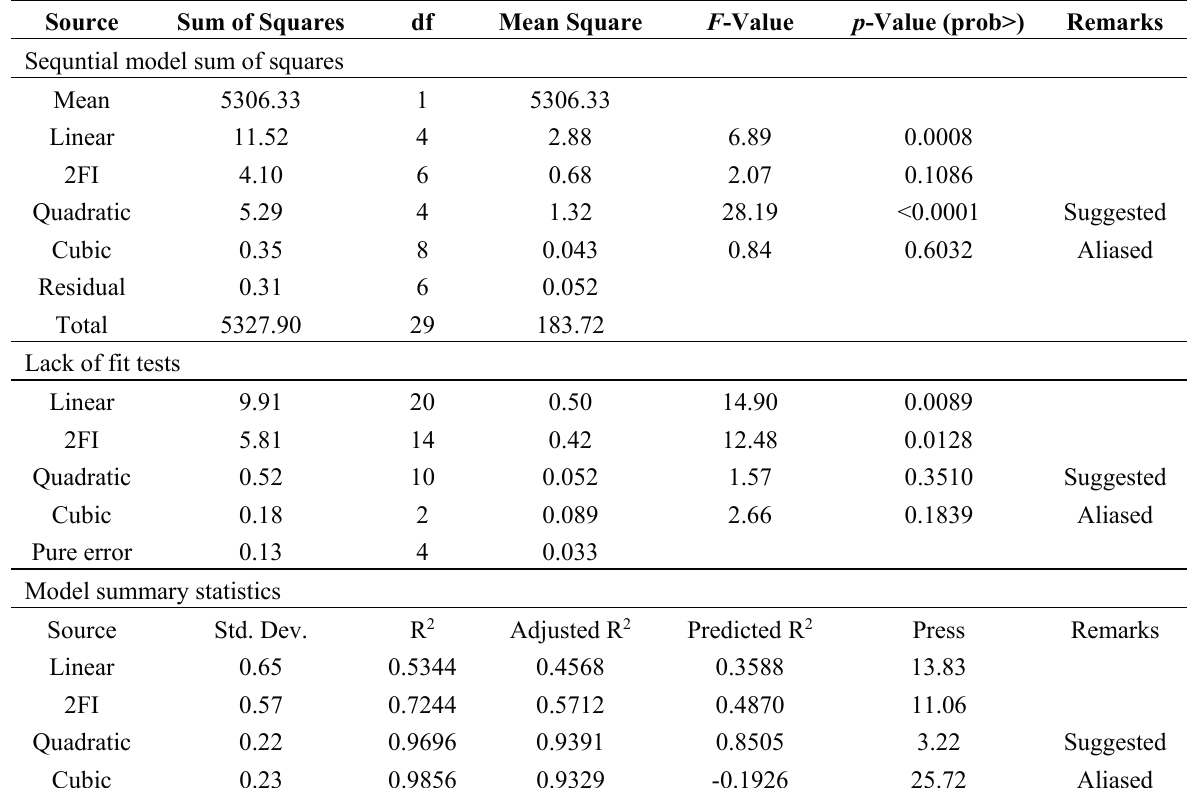
Table 2. Sequential model fitting for the extraction yield of